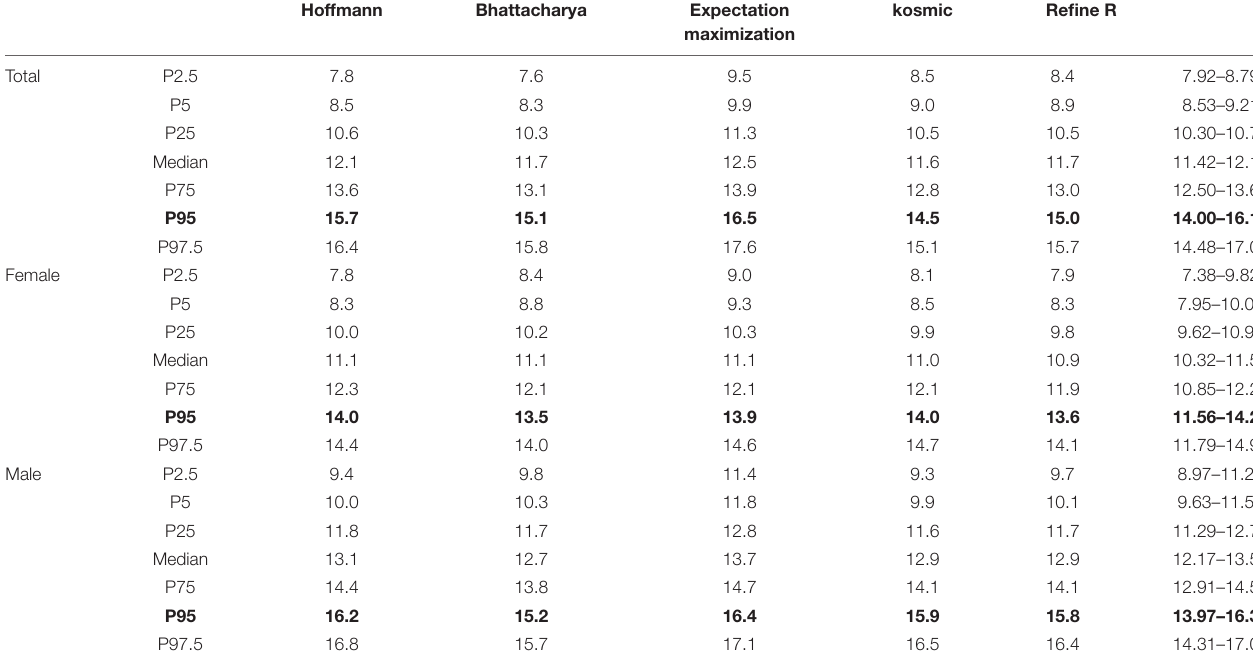
TABLE 4 | Reference interval of Hcy established by using five